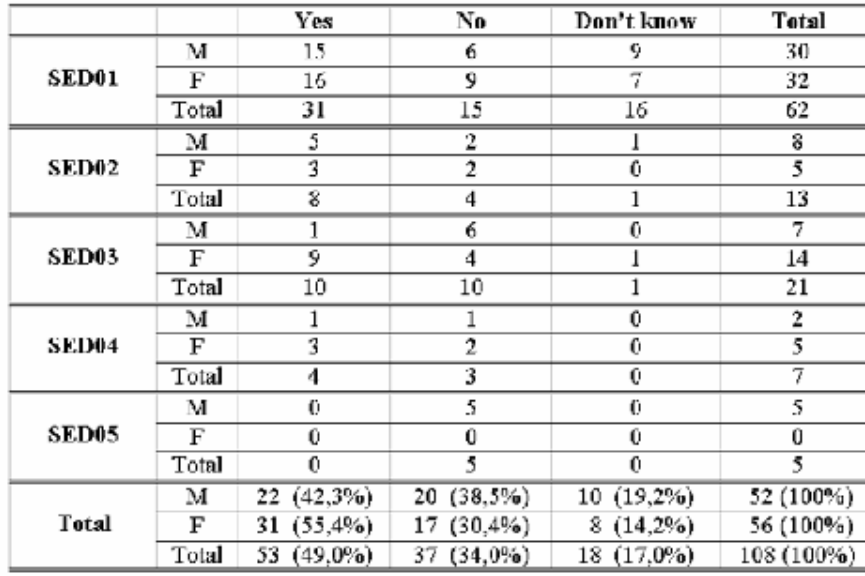
Table 11. Intentions of students who dropped out to re-enroll in the same subject ( m = male, f =